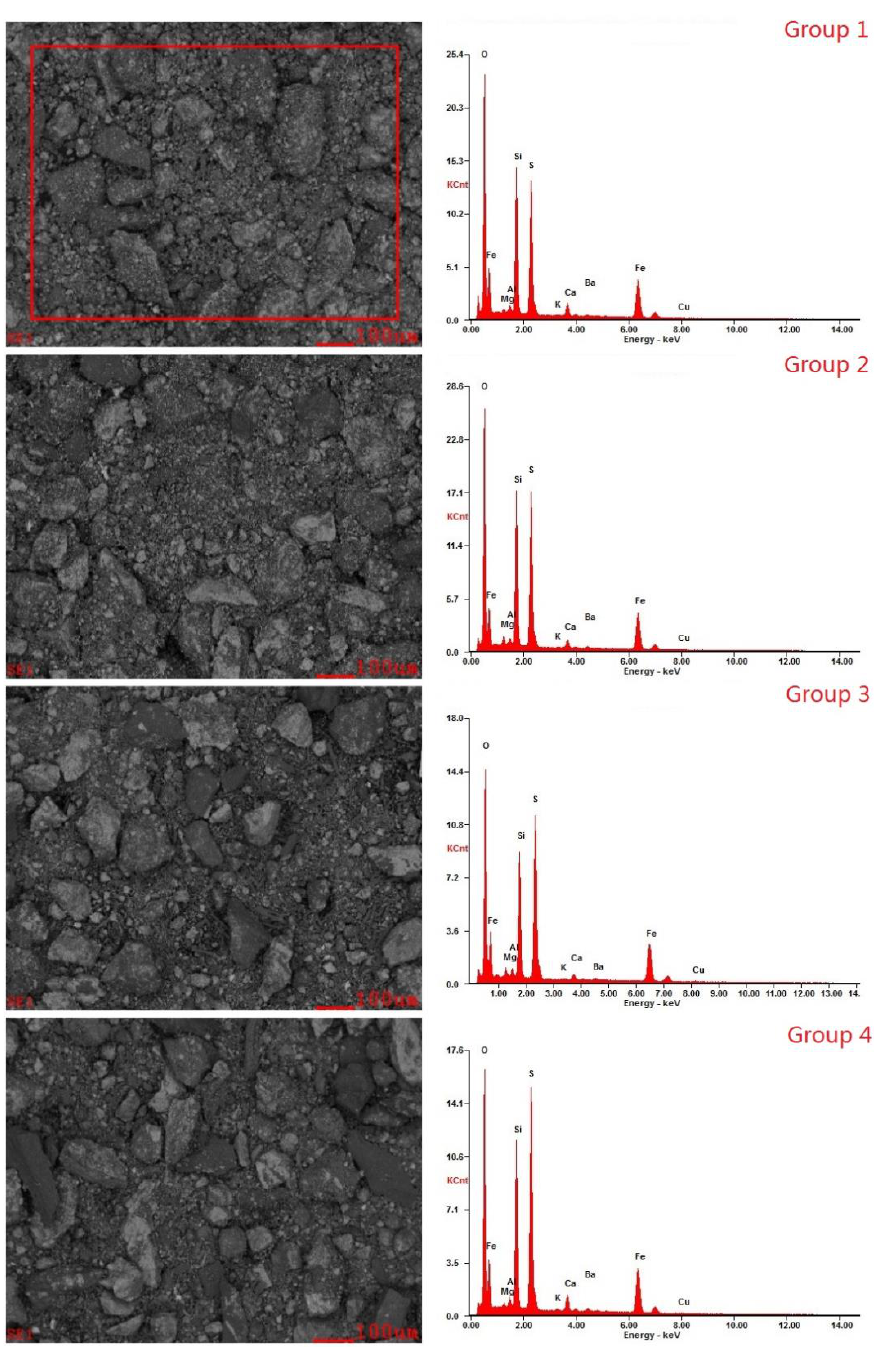
Figure 5. The energy spectrum and backscatter diagram.